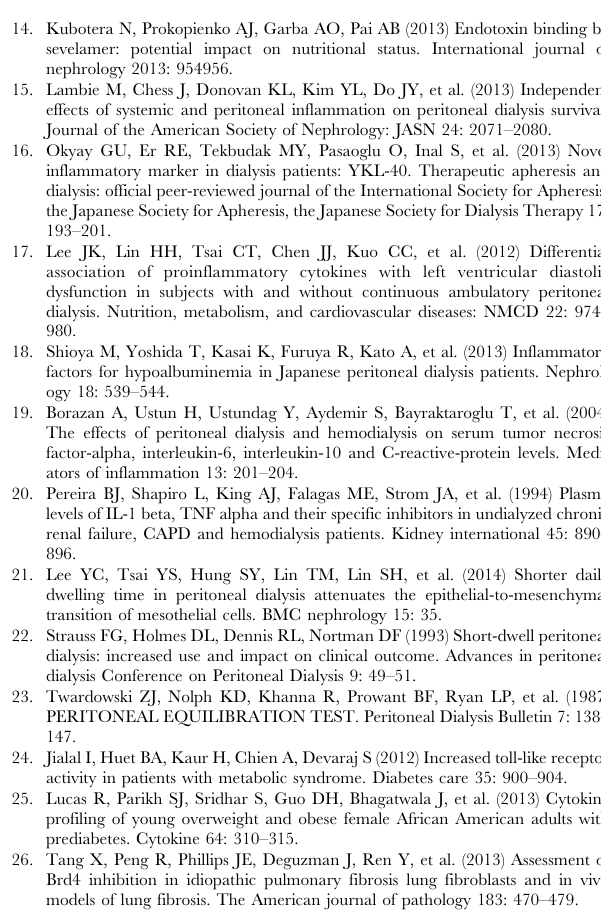
Figure S1 Principal-component analysis (PCA) loading plot (a) and scores plot (b). (a) The first principal component (PC-1) accounts for 23.3% of the variance and is primarily defined by dialysate/plasma creatinine ratio at 4 hours (4-h D/P creatinine), body mass index (BMI), body surface area (BSA), Charlson’s comorbidity index (CCI), glycated hemoglobin (HbA1c) and hemoglobin (Hb). The second principal component (PC-2) accounts for 16.9% of the variance and is defined by serum creatinine, phosphorus (P), age, weekly creatinine clearance (CrCL), uric acid, intact parathyroid hormone (iPTH), PD duration, ferritin, and albumin. The third principal component (PC-3) accounts for 11.2% of the variance and is defined by normalized protein nitrogen appearance (nPNA), serum calcium (Ca), cholesterol and white blood cell count (WBC). (b) Scores plot of 26 patients in a three-dimensional space derived from PCA.